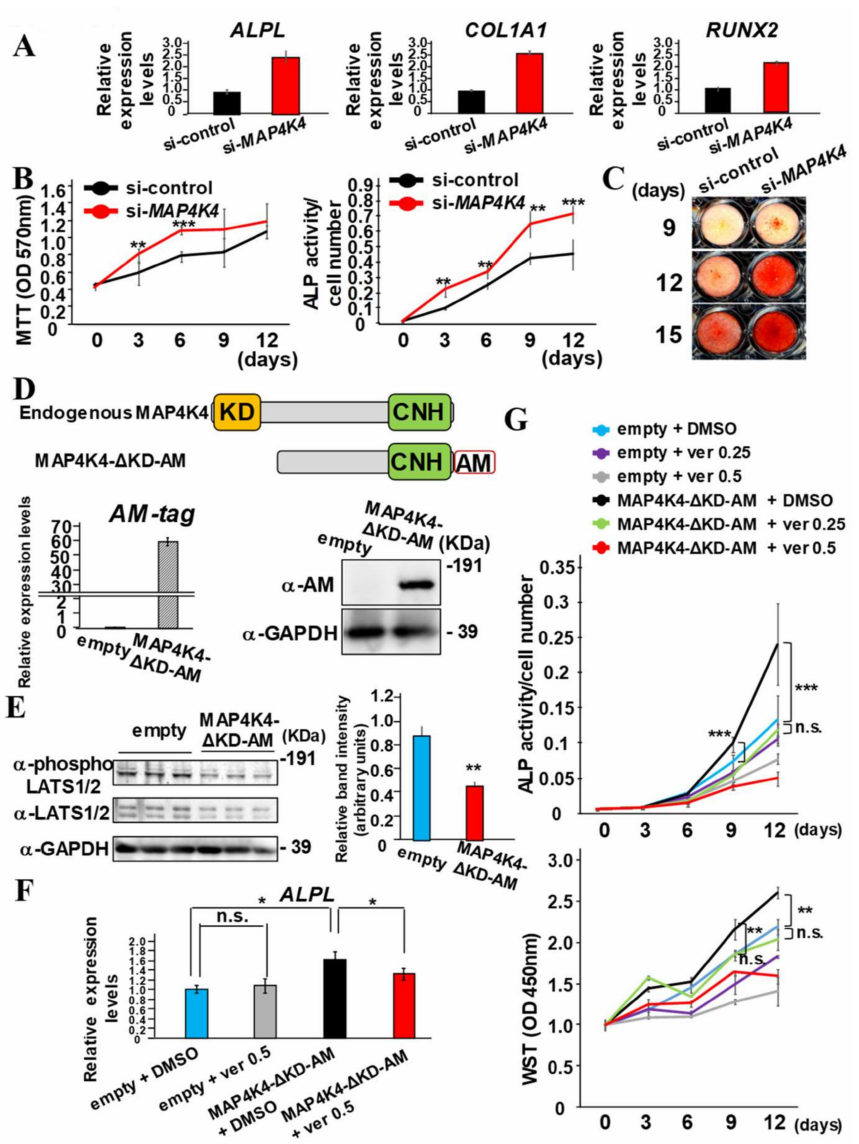
Figure 7. MAP4K4 kinase inhibition promotes cell proliferation and osteo/cementogenic differenti- ation of PDLF. ( A ) PDLF were transfected with si-control or si- MAP4K4 for 24 h and then re-seed with high density and then cultured for another 24 h. Then, total RNA was collected to quantify